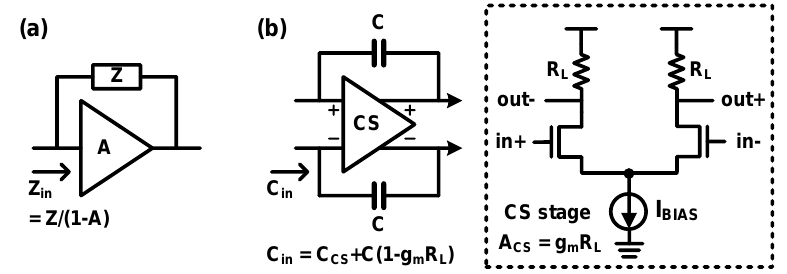
Figure 36. ( a ) Miller effect ( b ) Miller capacitance applied in a differential CS stage in [91].